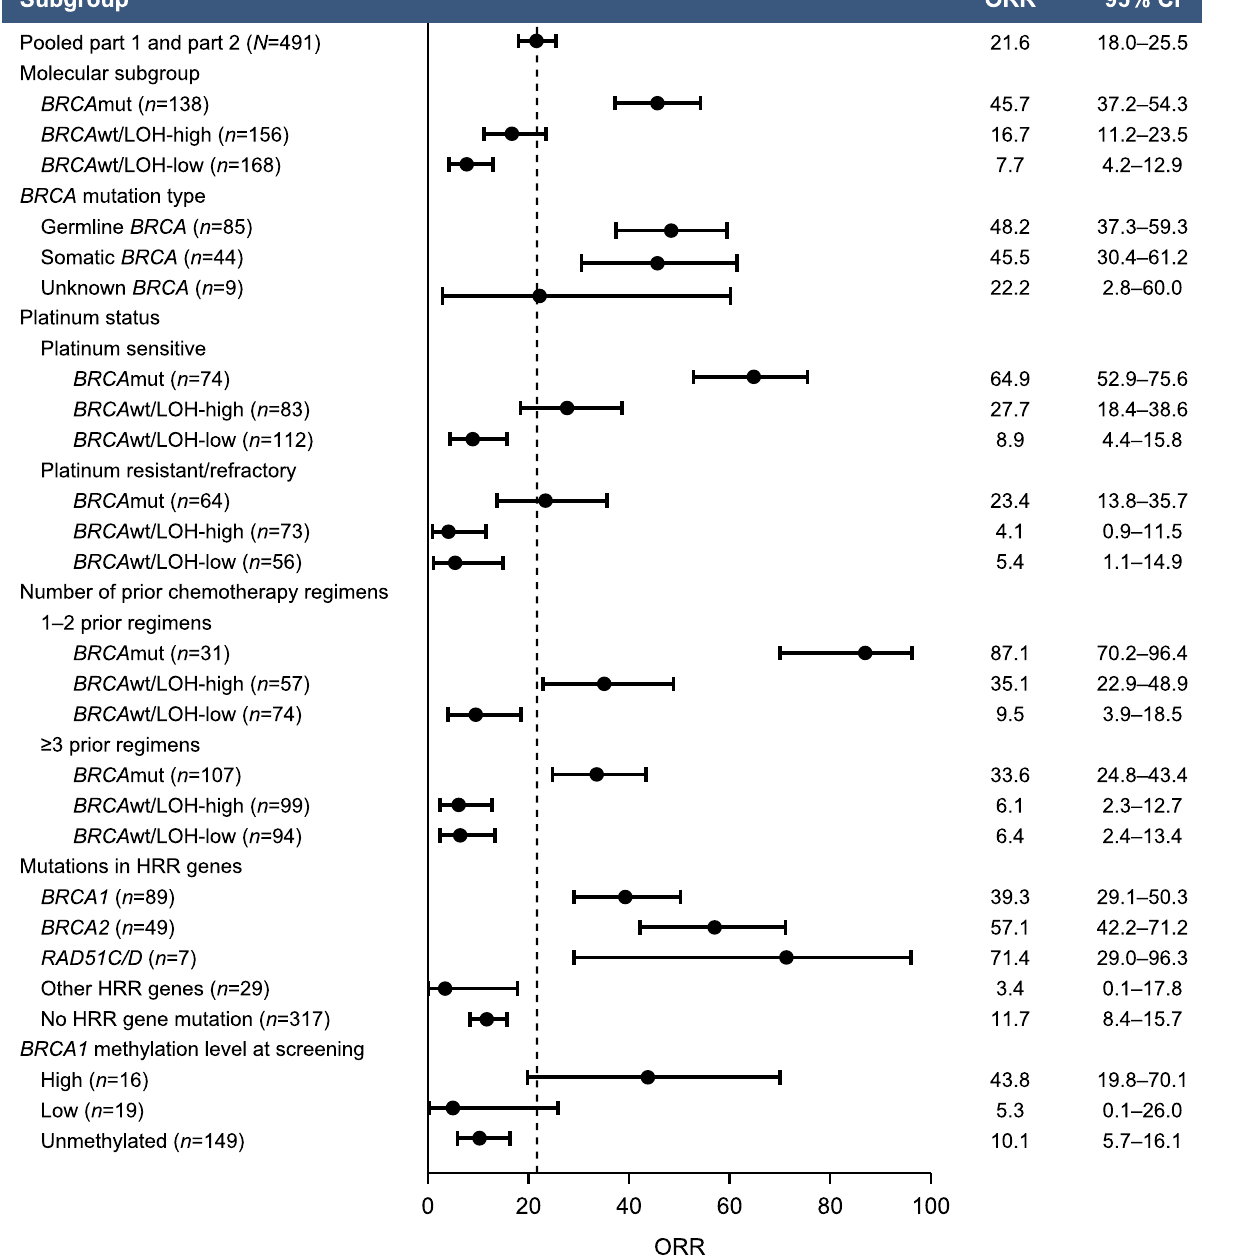
Fig. 2 ORR based on post hoc molecular subgroups and baseline clinical characteristics. Data are plotted as ORR (dots) with the corresponding two- sided 95% CI (error bars) based on the Clopper – Pearson method. BRCA BRCA1 or BRCA2 , CI con fi dence interval, HRR homologous recombination repair, LOH loss of heterozygosity, mut mutated, ORR objective response rate, wt wild